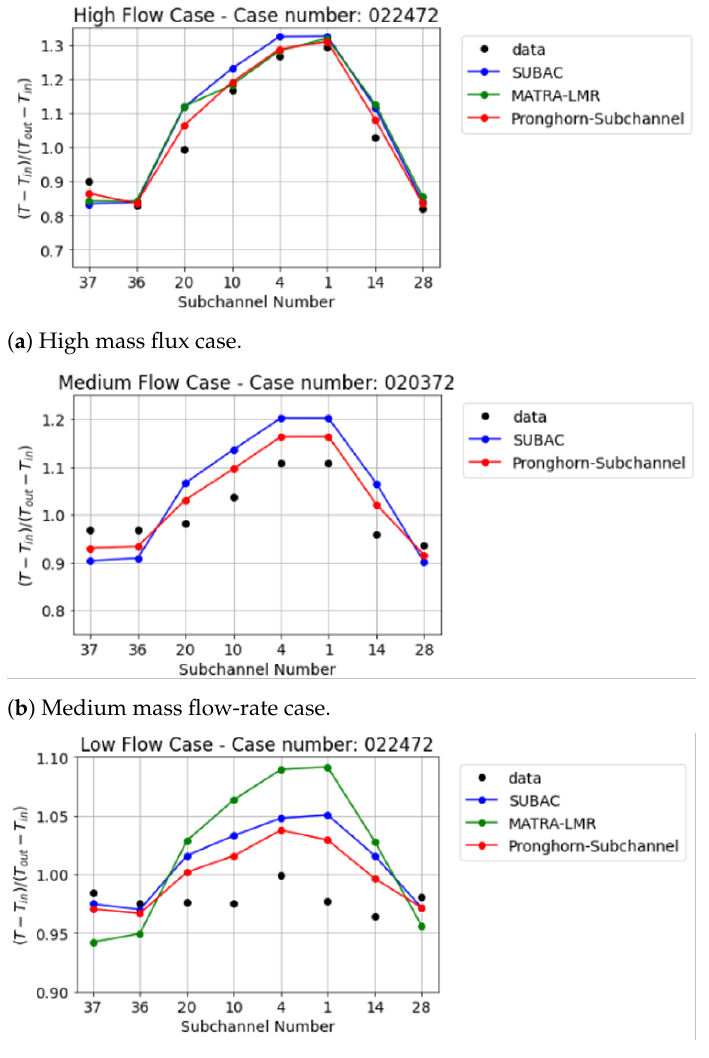
Figure 7. Comparison of results obtained for the ORNL 19-pin case between experimental measure- ments, the SUBAC code, the MATRA-LMR code and Pronghorn-SC. ( a ) High mass flow-rate case. ( b ) Medium mass flow-rate case. ( c ) Low mass flow-rate